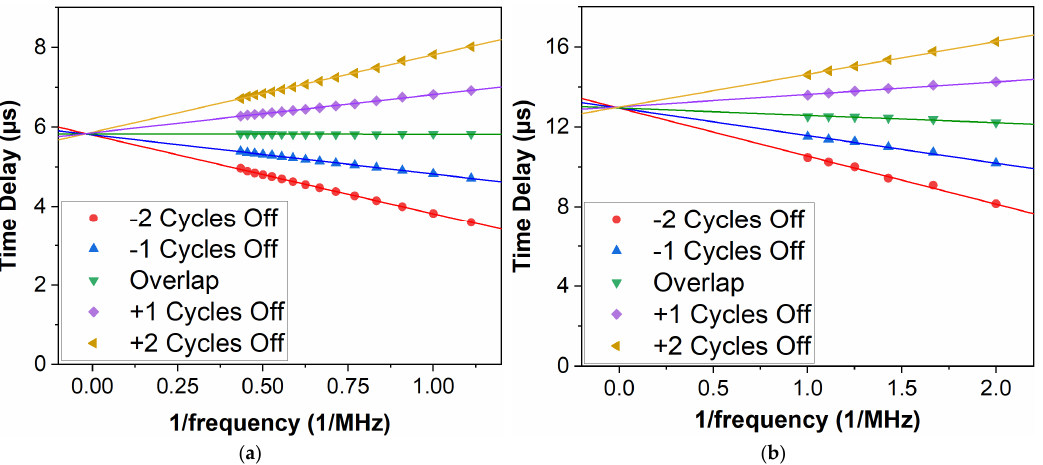
Figure 8. ( a ) Longitudinal time delay between the excitation and output signal vs. 1/frequency; ( b ) shear time delay between the excitation and output signal vs. 1/frequency. The average Young’s modulus obtained using tensile testing was 2.906 ± 0.073 GPa. This represents a difference of 1.92% with respect to the value determined using